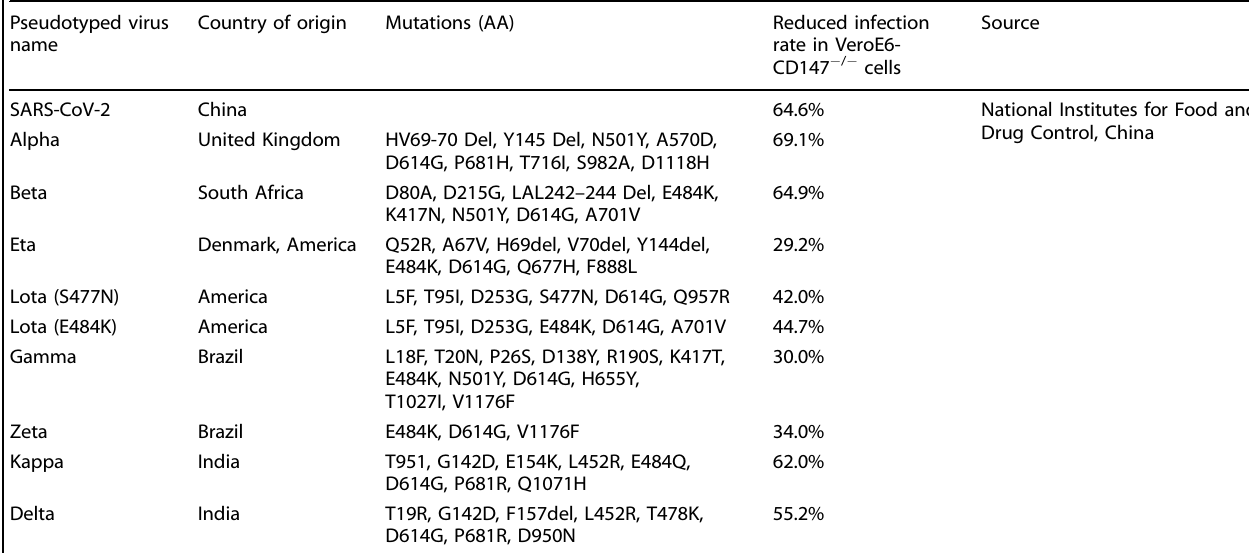
Table 2. SARS-CoV-2 pseudotyped variants features and the reduced infection rate in VeroE6-CD147 − / − cells